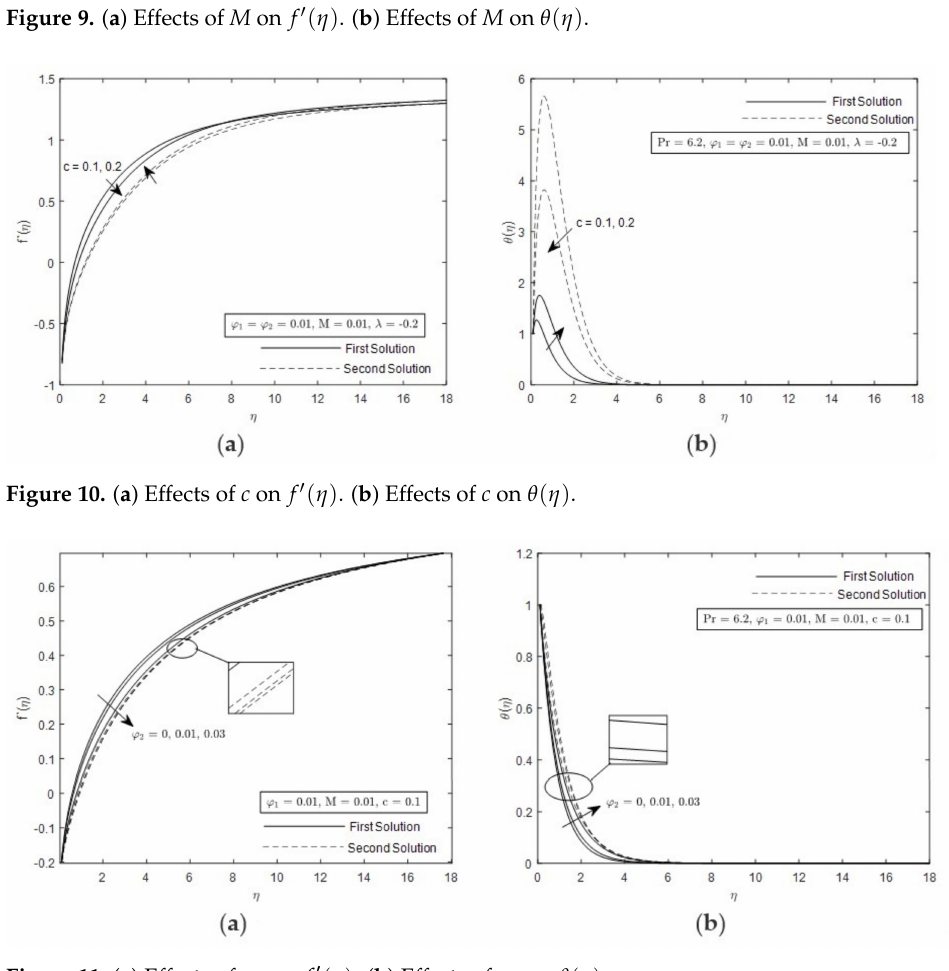
Figure 11. ( a ) Effects of ϕ 2 on f (cid:48) ( η ) . ( b ) Effects of ϕ 2 on θ ( η )